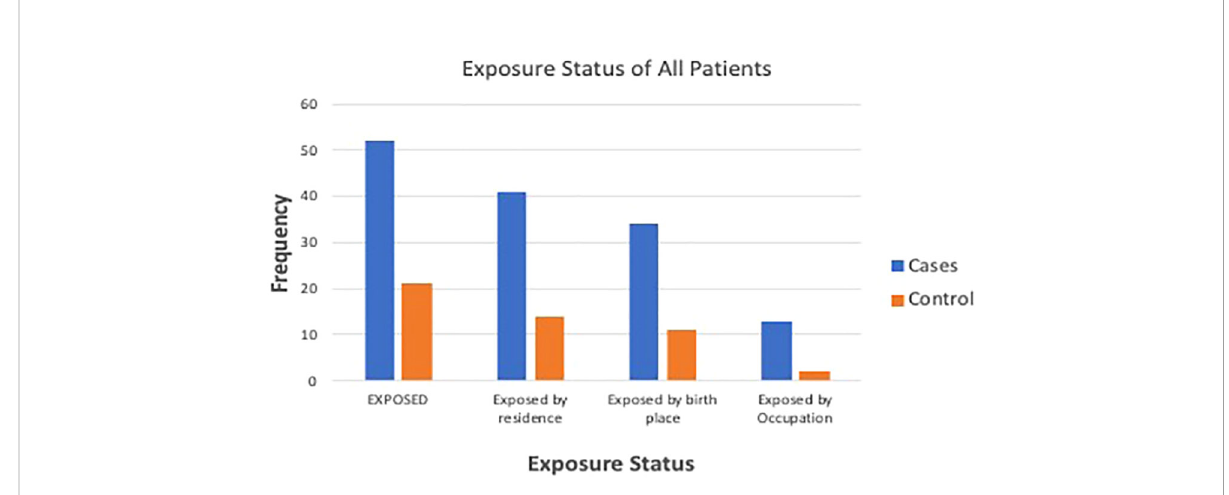
FIGURE 1 Exposure status of the